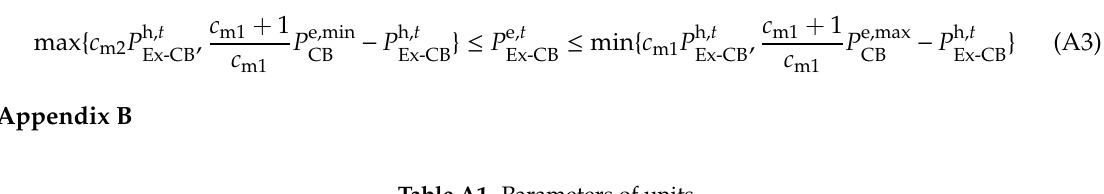
Table A1. Parameters of units.